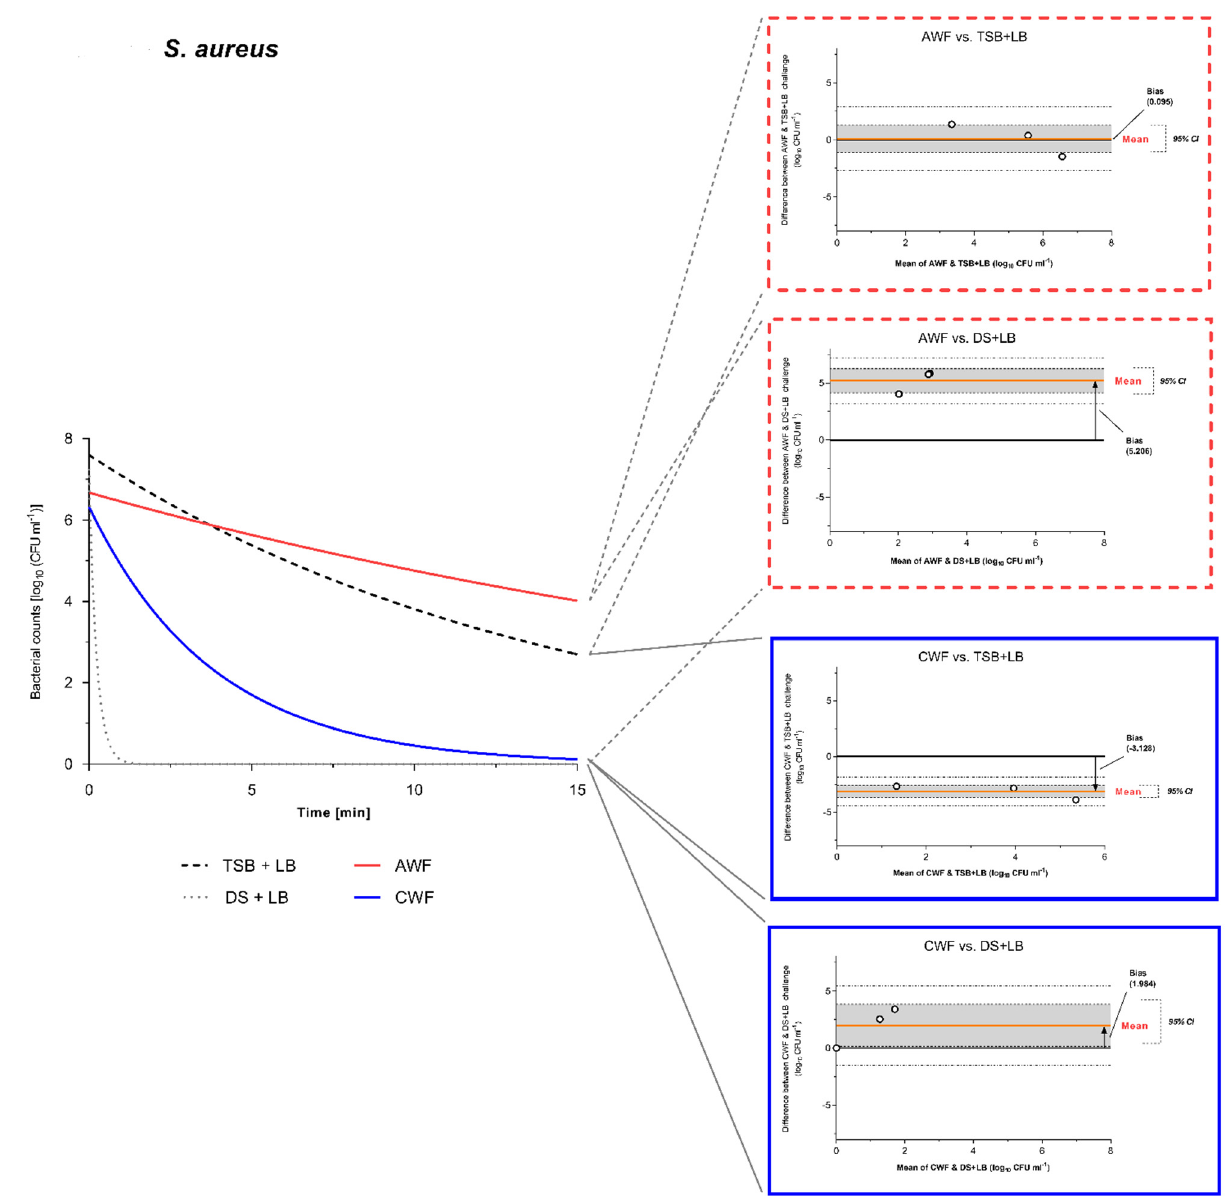
Figure 6. Bland-Altman (B&A) plot comparing bacterial reduction results against S. aureus under AWF challenge to TSB + LB and DS + LB. Best fitted curves of the reduction in bacterial counts over the course of 15 min exposure time for AWF (red line), CWF (blue line), DS + LB (dotted line), and TSB + LB (dashed line) are depicted on the left. Bland-Altman plots for the comparison between different challenge methods are shown on the right (dashed red frame for comparisons against AWF; blue solid line against CWF). Red line labeled “mean” marks the mean bias between the compared methods and deviation from the line of equality (y = 0). Grey area around the mean marks the 95% confidence interval. If the line of equality (y = 0) is enclosed in the 95% CI, no significant difference between methods can be postulated, if the line is excluded from the 95% CI, the methods provide significantly different results. The bias is stated numerically in the form of units measured (here log 10 CFU/mL).